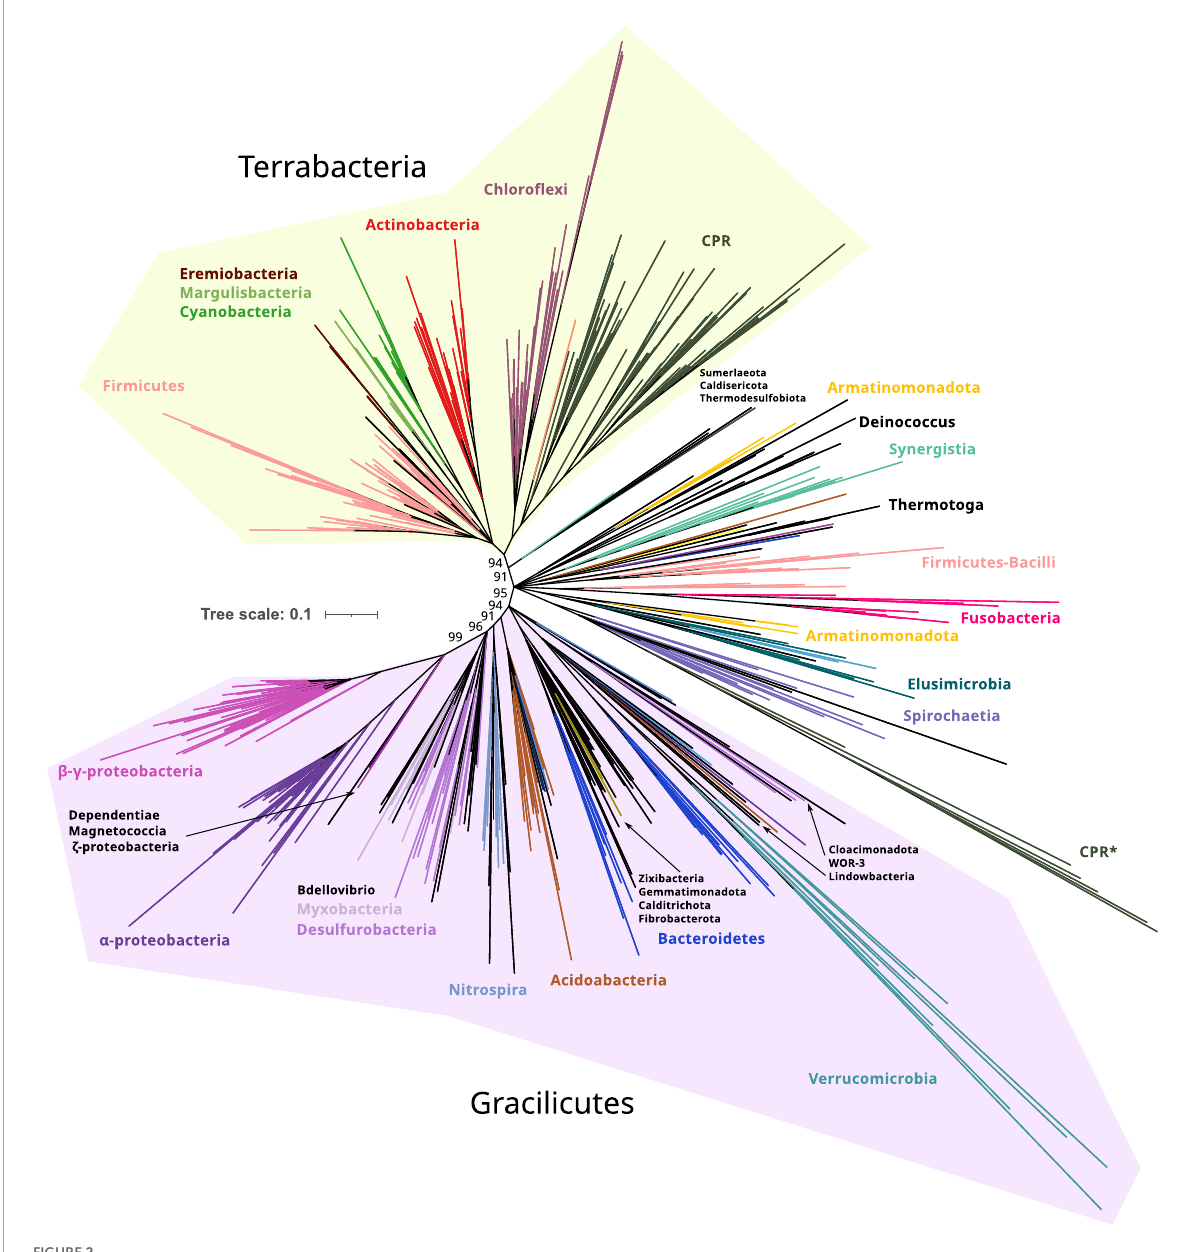
FIGURE2 Phylogeny of only bacterial FtsZs. Branches are colored according to taxonomic phyla and GTDB nomenclature (release bac120, arc122). The dataset was reduced by redundant filtering by taxonomic classes and then selecting one sequence for each taxonomic order. The final MSA consisted of 534 sequences and 334 positions, denoted as manual trimming. The phylogeny was built using IQ-TREE, automatic model selection (LG + R10), and ultrafast bootstrap (UFBoot2). Refer to Supplementary Figure 1 , for corrected bootstrap trees with NNI searches, different trimming methods, and evolutionary models. To ease the visualization of the most basal supported nodes, nodes with lower support than 85% were removed and only UFBoot2 values at basal nodes of interest were shown. Terrabacteria and Gracilicutes supergroups are highlighted in yellow and purple, respectively (refer to the extended tree in Supplementary Figure 3 ). Original and trimmed analyses and Newick trees are provided in Supplementary Data